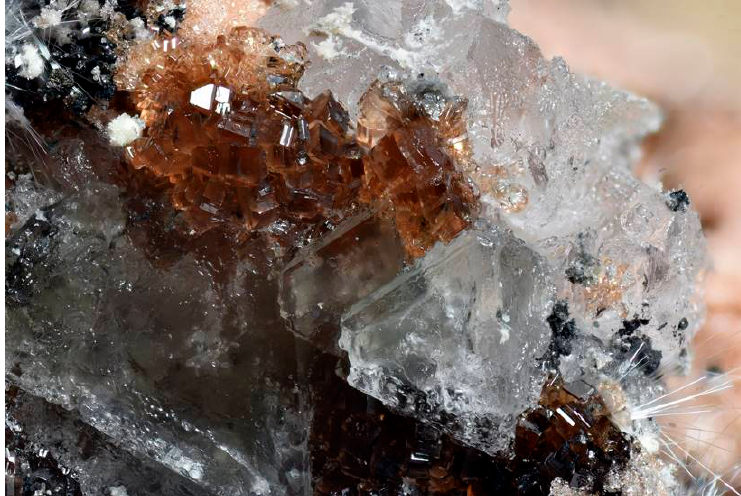
Figure 2. Alum-(K) from the Fornovolasco mine, as octahedral colorless crystals up to 5 mm in size, with brown römerite and acicular crystals of halotrichite.